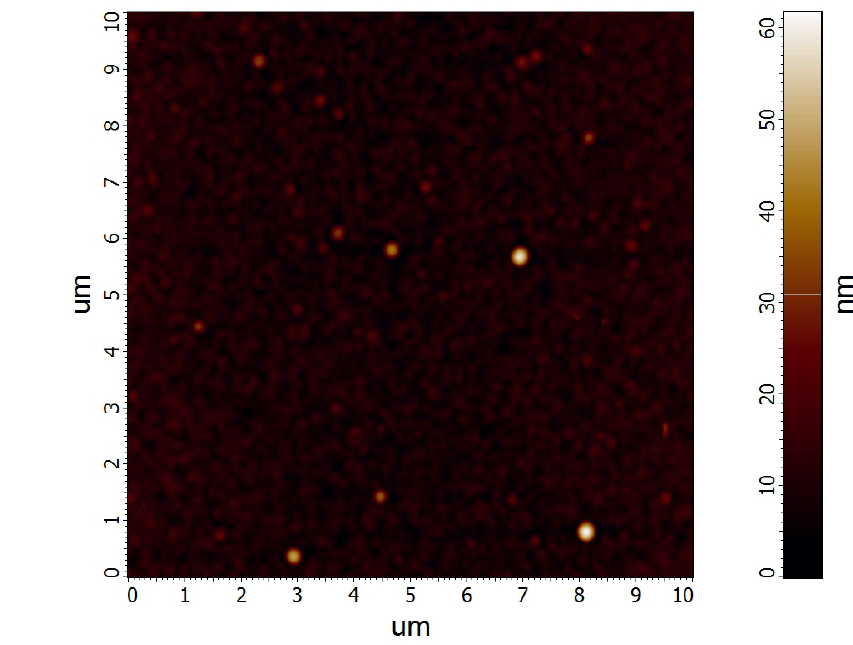
Figure 6. AFM image of the surface of the studied POx